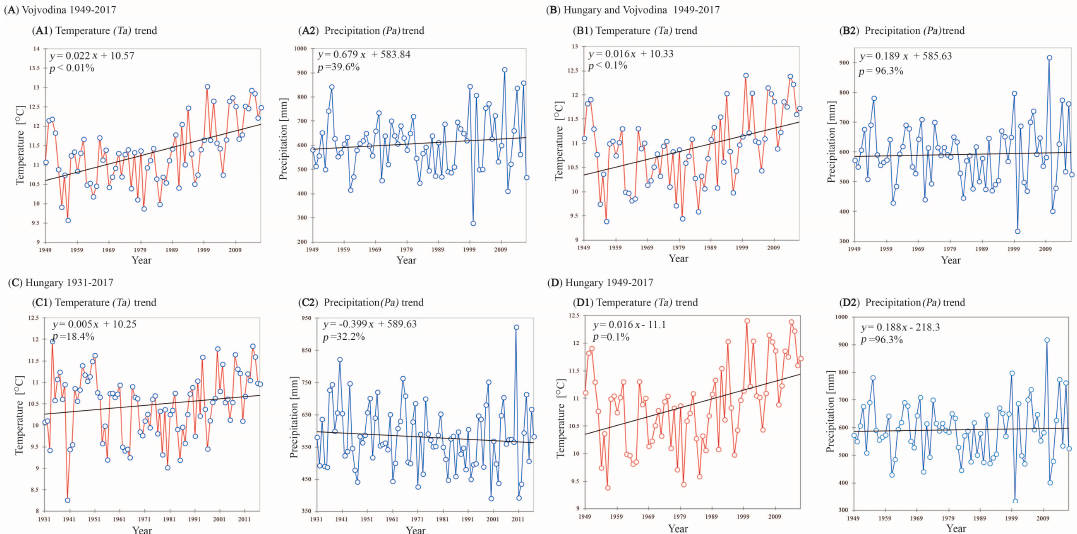
Table 3. Summary results of Mann-Kendall (MK) tests for temperature and precipitation trends for Vojvodina in the period 1949 – 2017, Hungary in the period 1931 – 2017; and Hungary and Vojvodina jointly in the period 1949 – 2017.